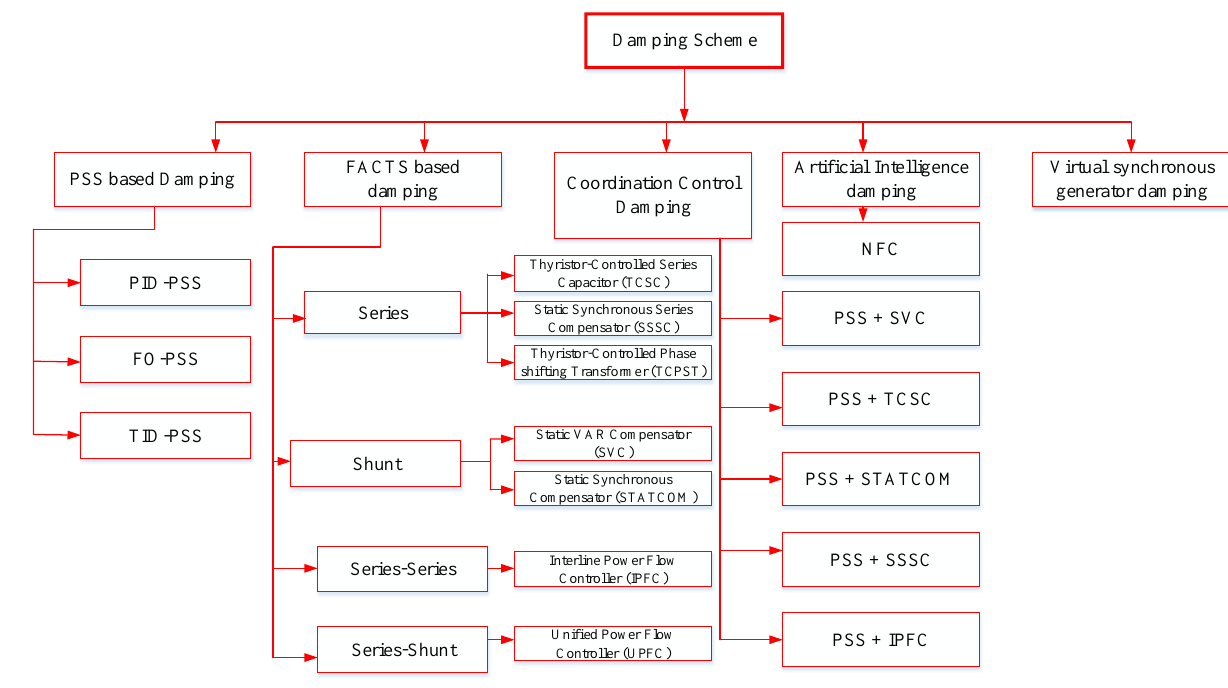
Figure 14. Damping schemes for power system oscillation [10]. Table 2. Provides a summary of the fundamental purpose of various damping schemes and their limitations.